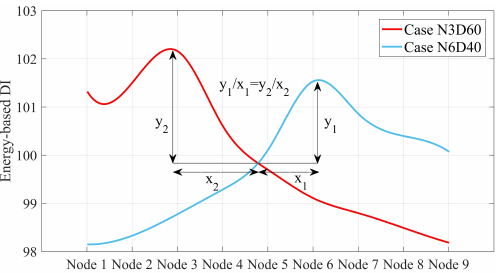
Figure 12. Relationship between maximum splines for cases with the same damage ratio (only for single damage scenarios) under moving sprung mass with a speed of 1.25 m/s.